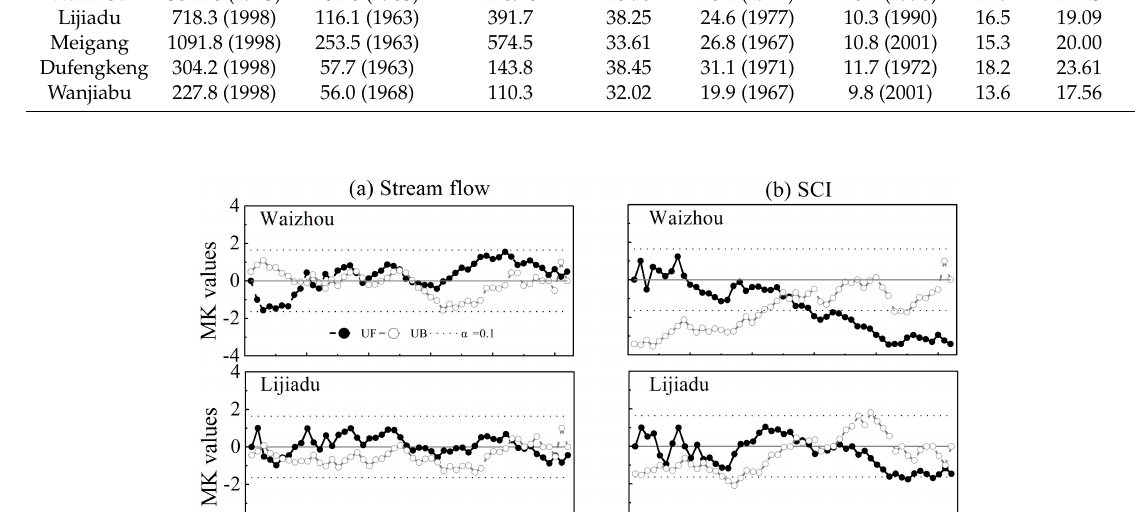
Table 2. Descriptive statistics of the annual stream flow at the five stations in the Poyang Lake Basin.